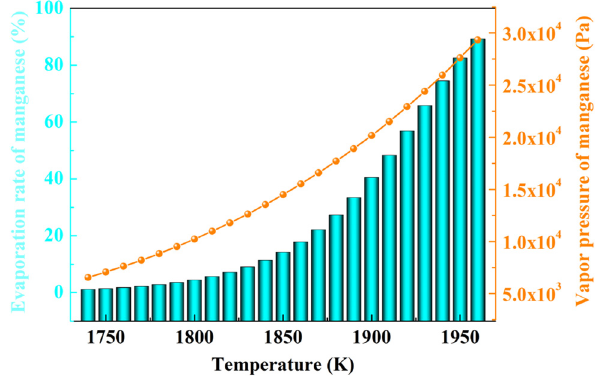
Figure 6: E ff ect of temperature on the vapor pressure and eva - poration rate of manganese.